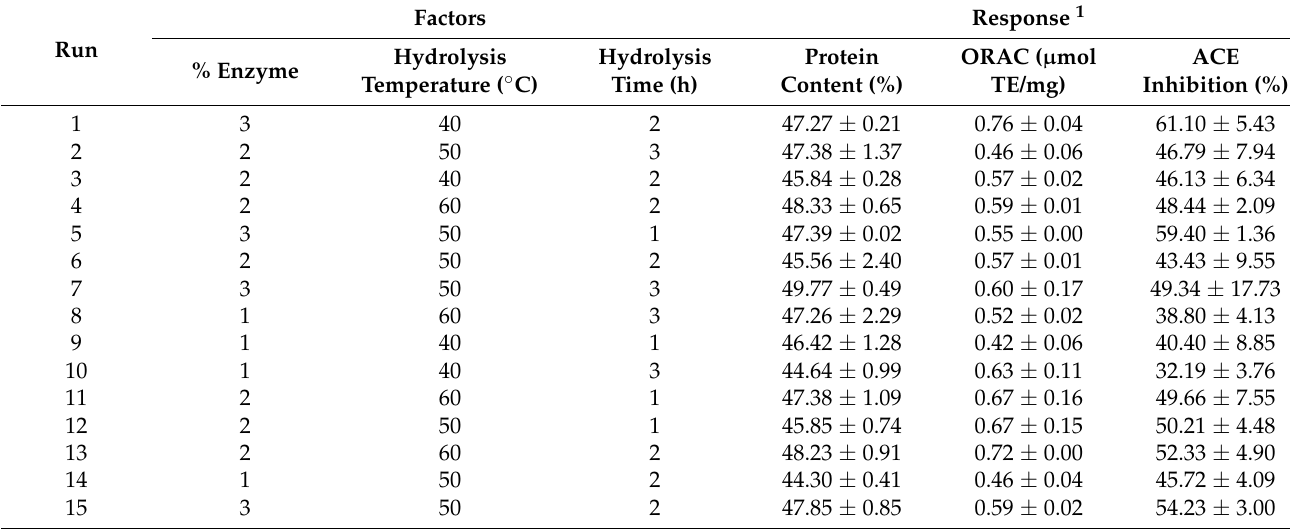
Table 7. Box-Behnken factorial design matrix for three factors and three responses obtained for the corolase protease.